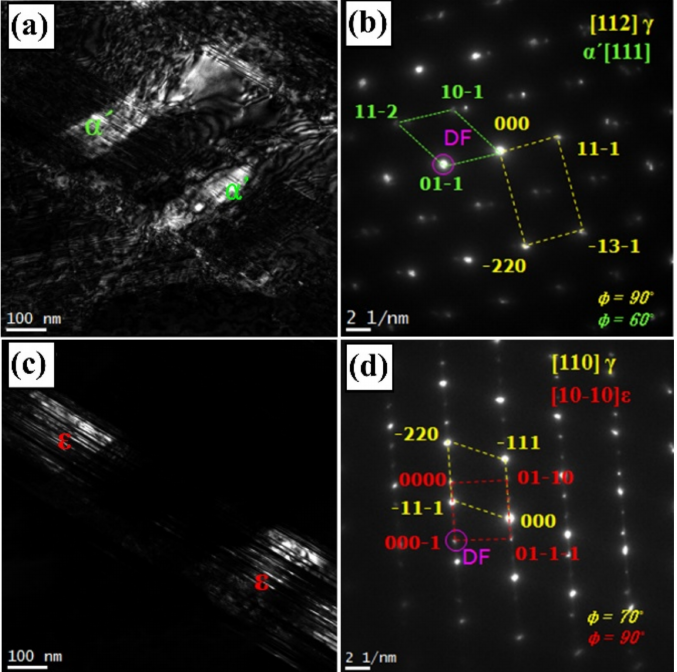
Figure 3. TEM images of martensite in the damaged Fe-22%Mn-12%Cr-4%Co-3%Ni-2%Si damping alloy under 175-MPa fatigue stress. ( a ) α (cid:48) -martensite, ( b ) index of ( a ), ( c ) ε -martensite, and ( d ) index of ( c ).